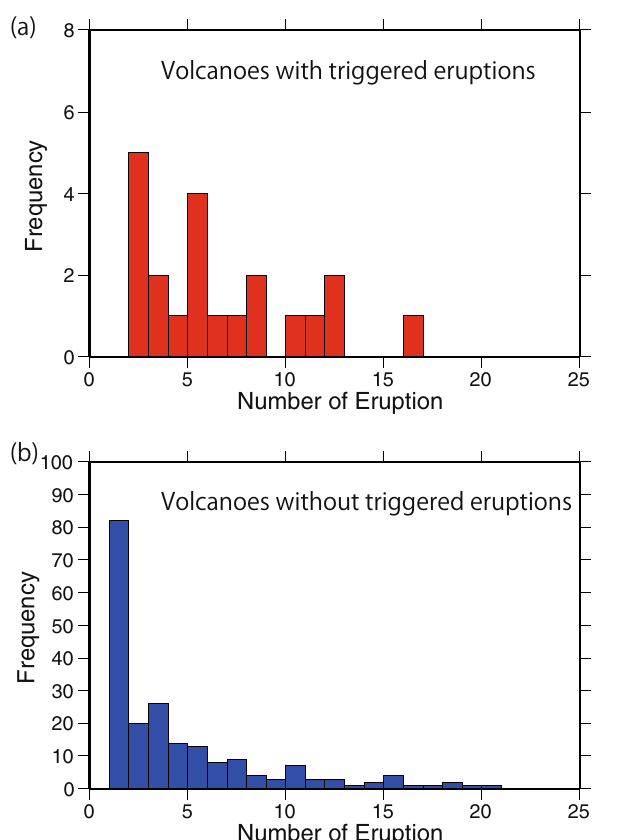
Figure 3. Frequency of volcanoes with a given number of eruptions over the 55 studied years for volcanoes ( a ) with and ( b ) without eruptions triggered by large earthquakes. This figure was created by Generic Mapping Tools (GMT) (version 4.5.5, https:// www. soest. hawaii. edu/ gmt/) 35 .